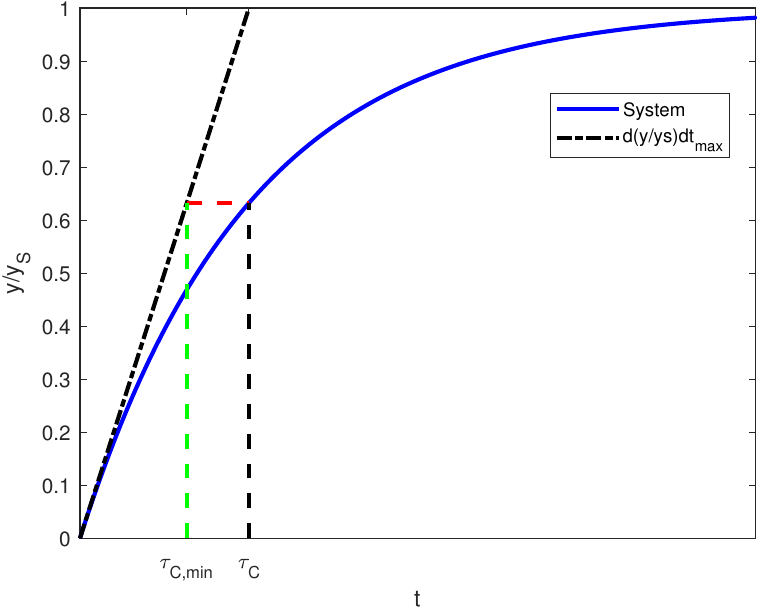
) as a function of the time constant. y s